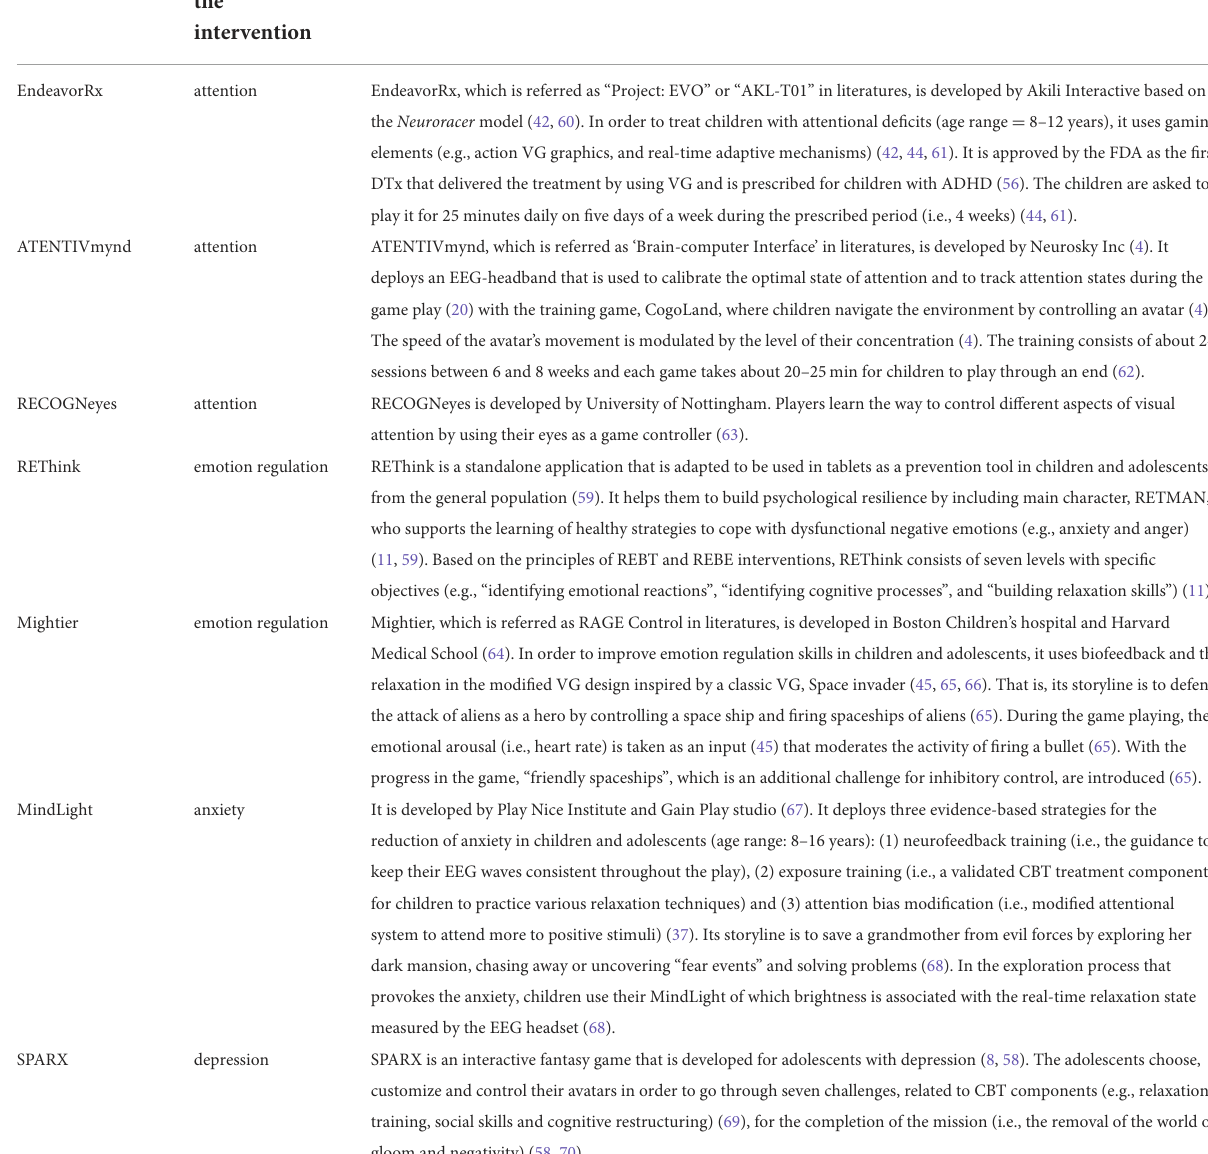
TABLE 1 The explanation of seven DTx for children and